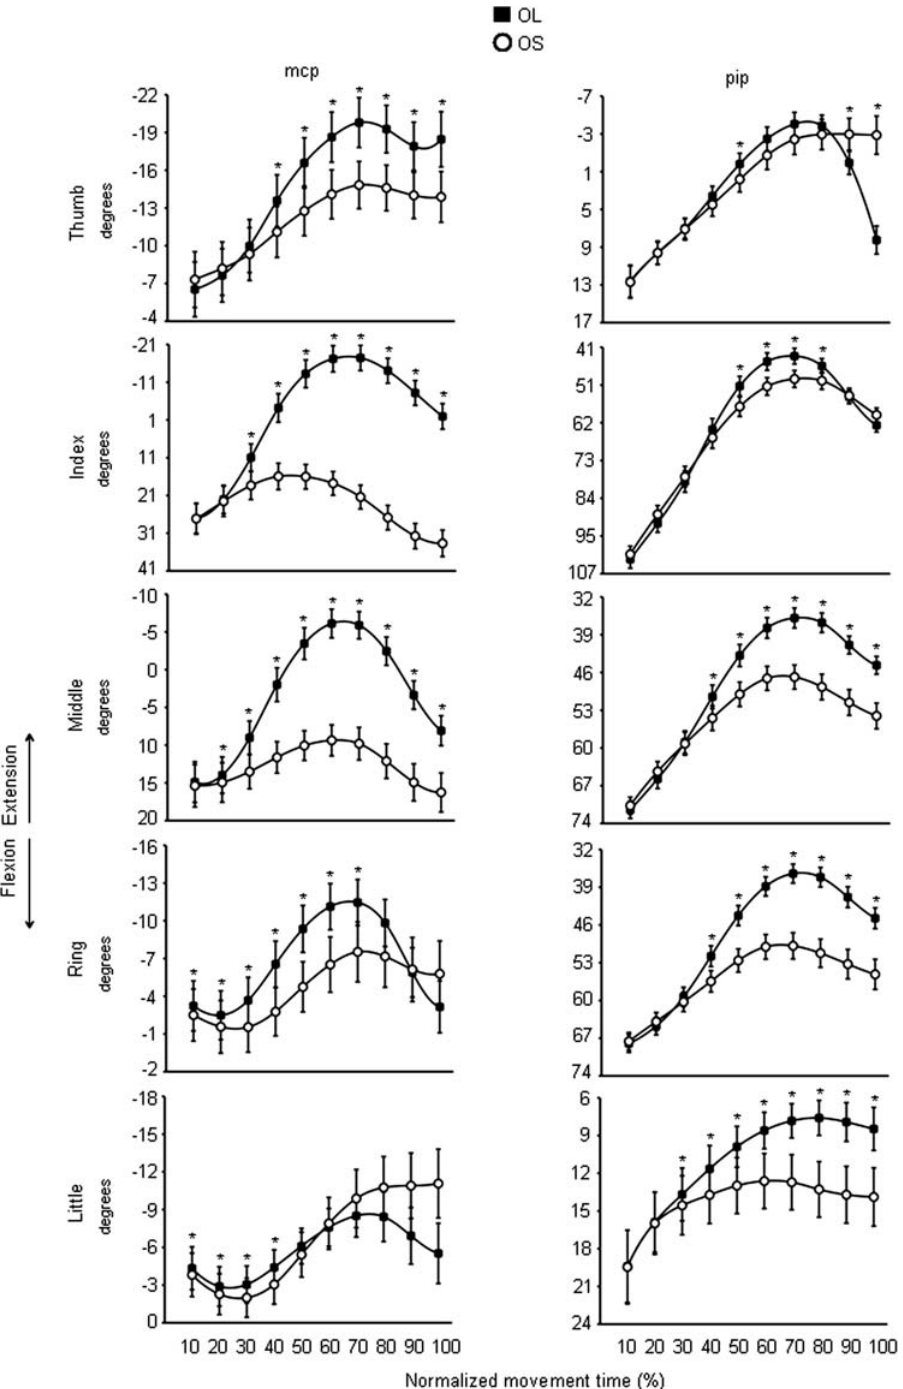
Figure 3. Time course of fingers motion during reaching in the absence of olfactory stimuli. Each trace corresponds to the average angular excursion for the mcp (left panels) and pip (right panels) joints of the thumb, index, middle, ring, and little fingers for the ‘OL’ (black squares) and the ‘OS’ (white circles) conditions. Bars represent mean standard error. Positive values correspond to finger flexion, whereas negative values correspond to finger extension. Asterisks indicate significant results ( p , .05) for the comparisons between the ‘OL’ and the ‘OS’ conditions at different epochs of normalized movement time. OL=Odourless air-Large target; OS=Odourless air-Small target.